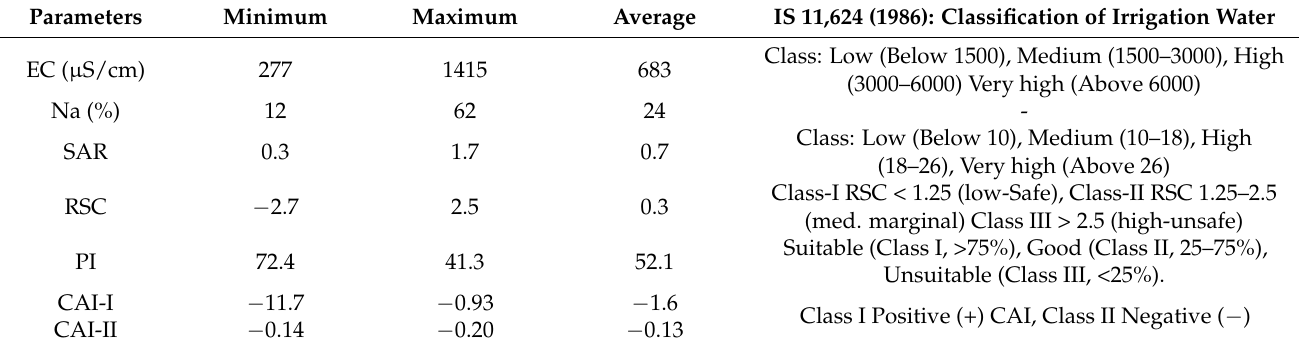
Table 3. Parameters’ value for classification of irrigation